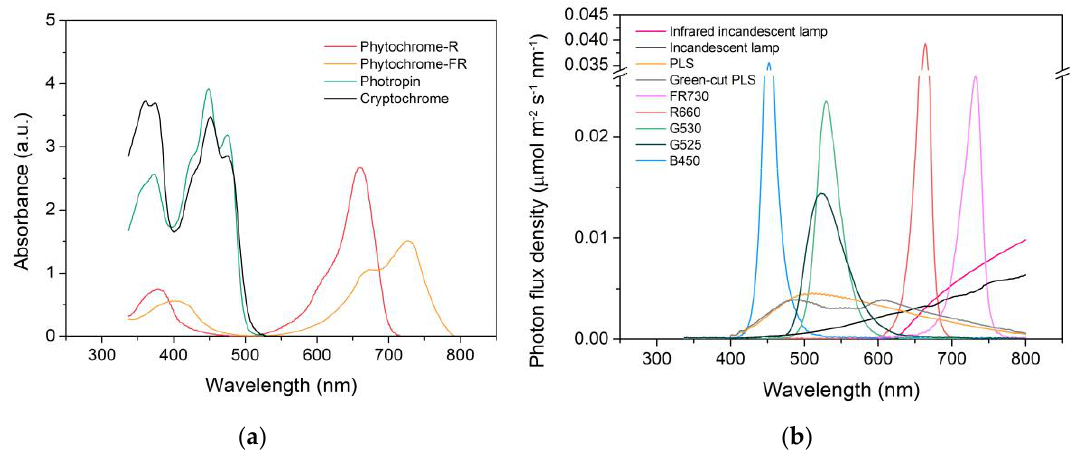
Figure 1. Spectral absorbance of plant photoreceptors ( a ) and emission spectra ( b ) of light sources used in this study. Spectral absorbances of photoreceptors were obtained from the literature (see Section 2.2). See Section 2.5 for abbreviations. a.u. indicates arbitrary unit.